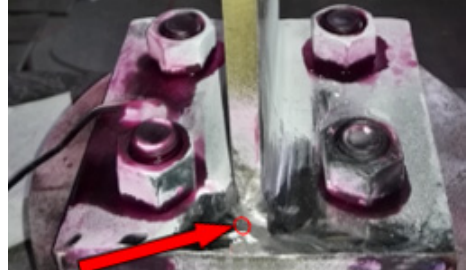
Figure 4. Welded joints with exposed heat affected